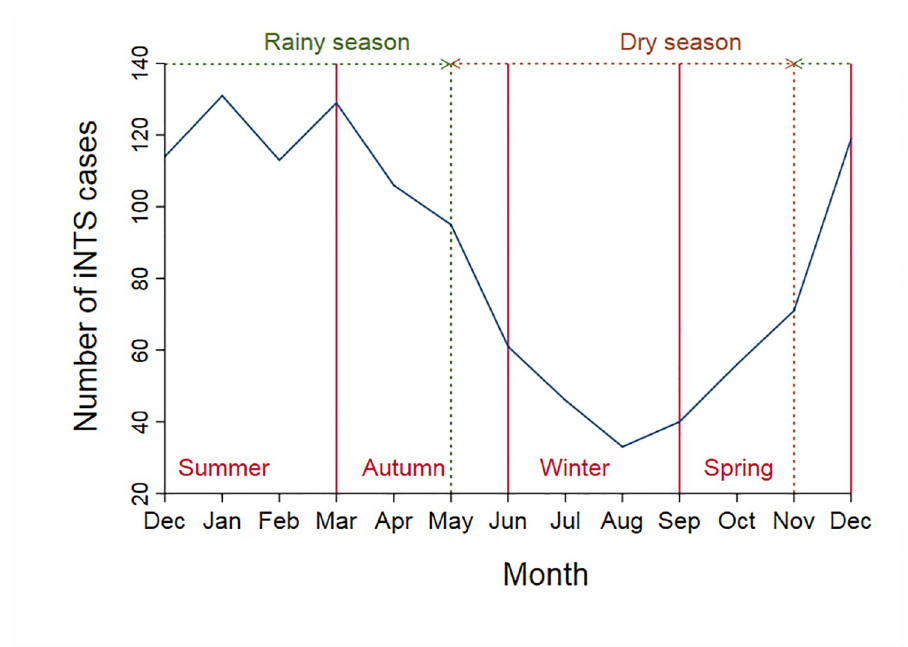
Fig 2. Number of iNTS cases in Queensland by month, 2007–2016.